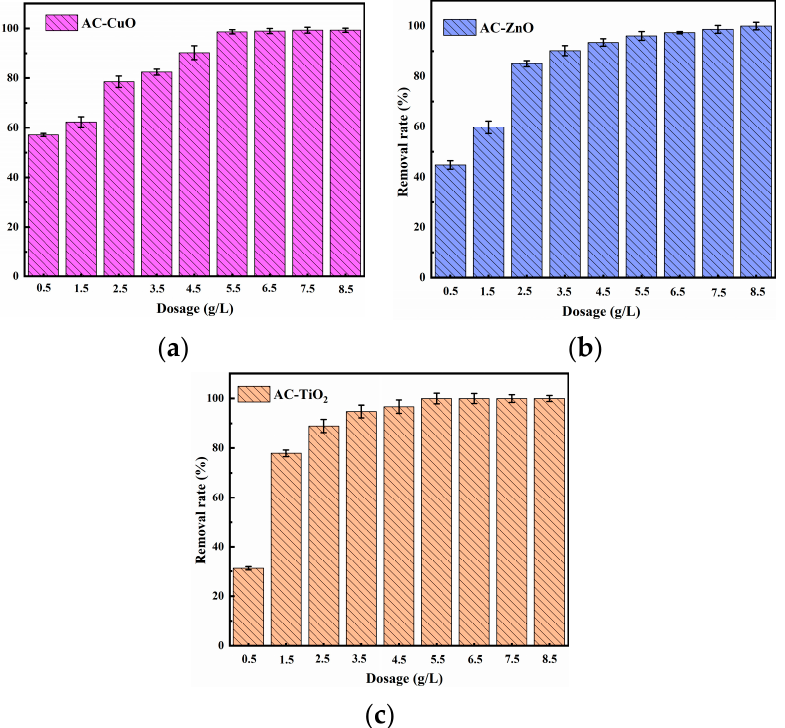
Figure 9. The effect of ( a ) AC-CuO; ( b ) AC-ZnO; ( c ) AC-TiO 2 dosages on the removal of methylene blue (initial concentration = 5 mg/L, contact time = 60 min, temperature = 25 ± 0.5 °C, initial Ph = 7.00).